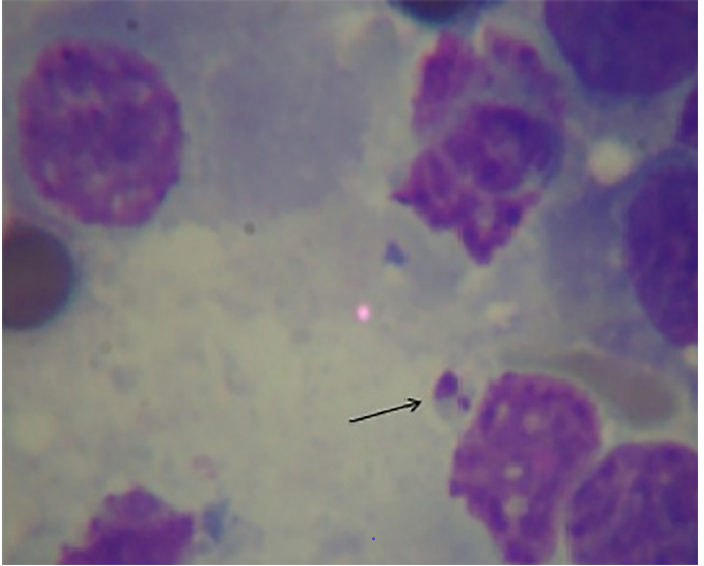
Figura 1. Parasitológico esfregaço de baço de cão soropositivo para leishmaniose. Forma amastigota livre (ponta